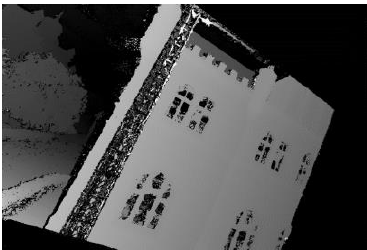
Figure 6. Disparity map of the first image pair computed using